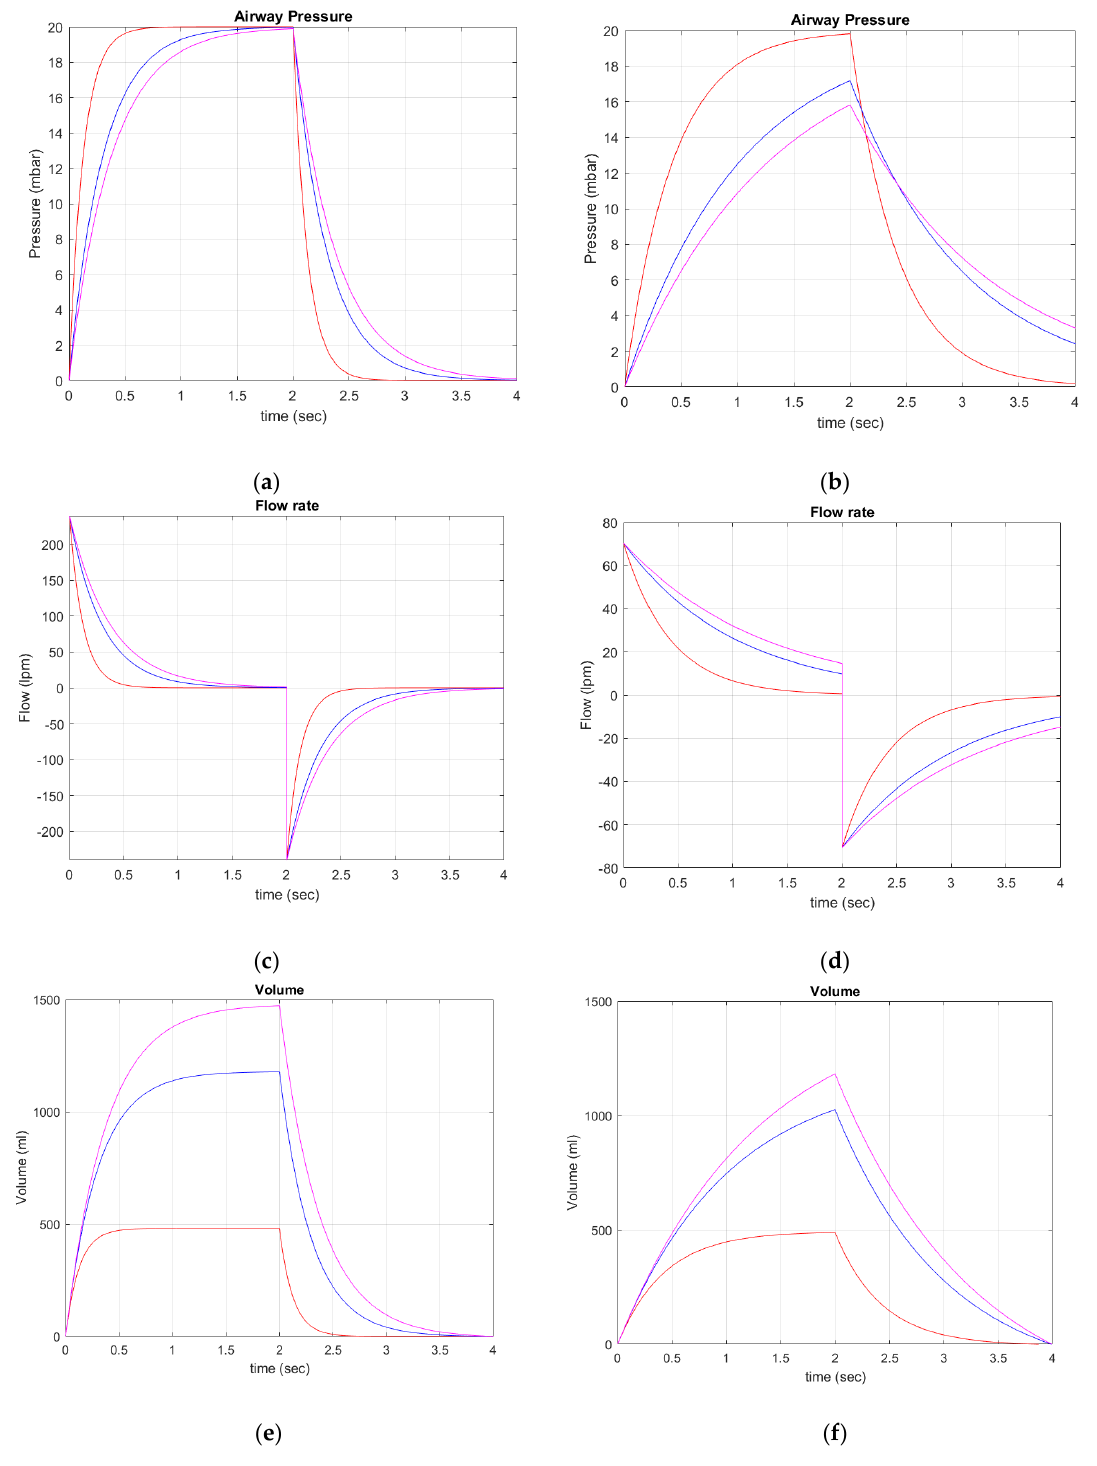
Figure 14. Simulation graph of pressure, flow, and volume. ( a , c , e ) Zero ventilator-related resistance. ( b , d , f ) Ventilator-related resistance of 12 mbar/L/s. Red graph is for lung resistance of 20 mbar/L/s and lung compliance of 0.025 L/mbar. Blue graph is for lung resistance of 20 mbar/L/s and lung compliance of 0.060 L/mbar. Magenta is for lung resistance of 20 mbar/L/s and lung compliance of 0.075 L/mbar. The source pressure for volume control is 20 mbar. Respiration rate is 15 bpm, and I:E ratio is